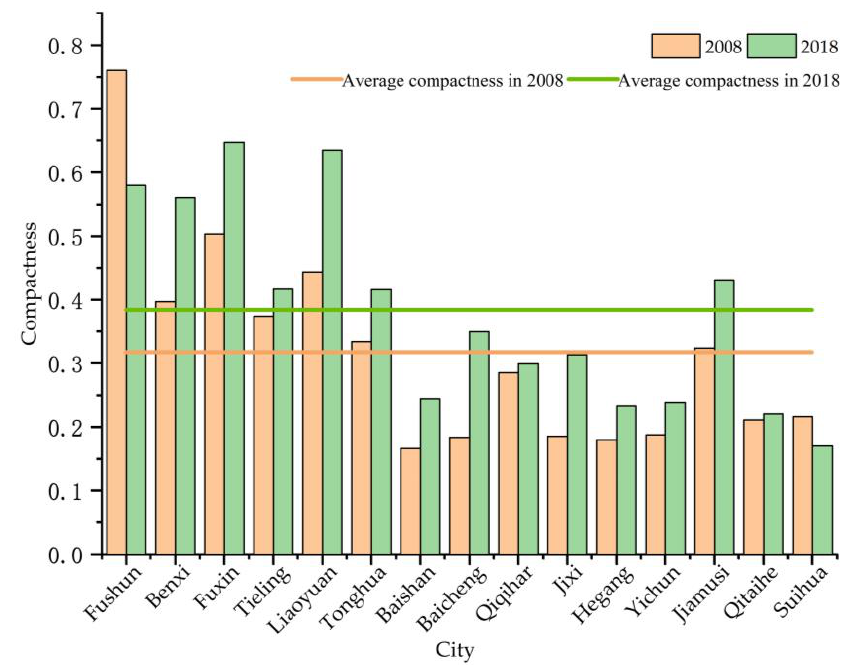
Figure 4. The compactness of shrinking cities from 2008 to 2018. The yellow line is the average compactness of the 15 shrinking cities in 2008; the green line is the average compactness of the 15 shrinking cities in 2018. (Source: Authors).